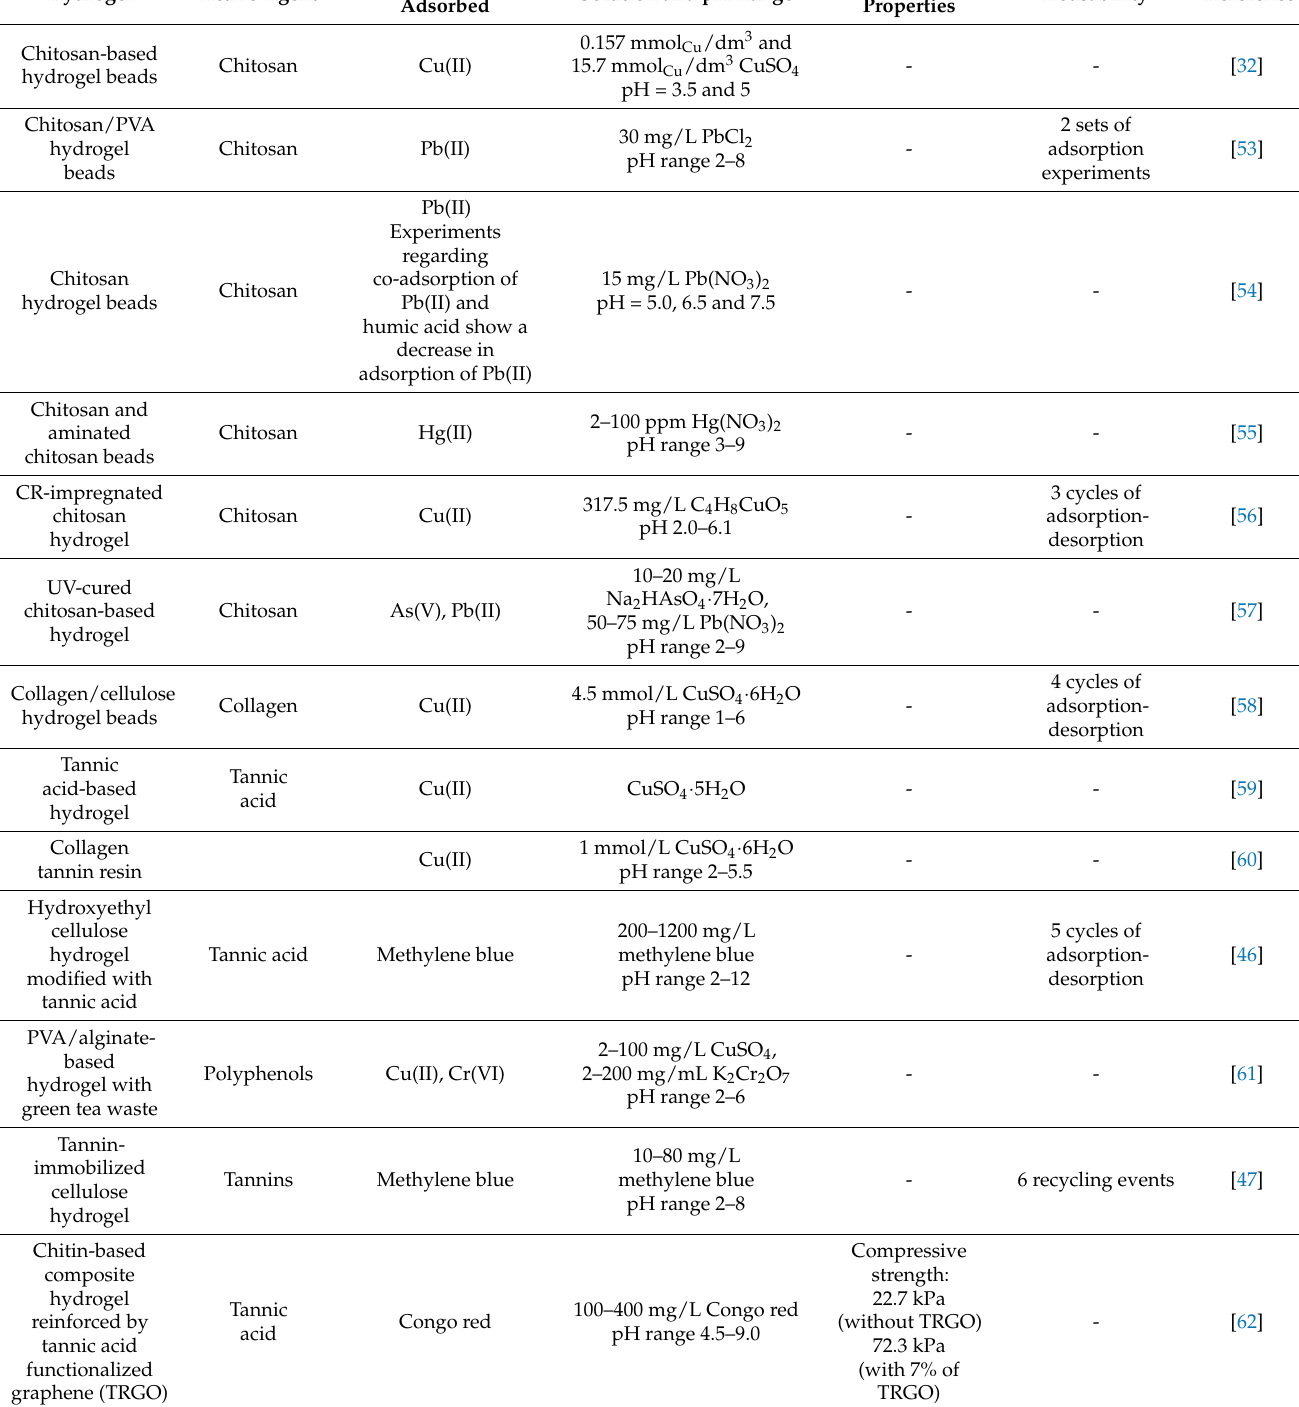
Table 1. Application of hydrogels for wastewater